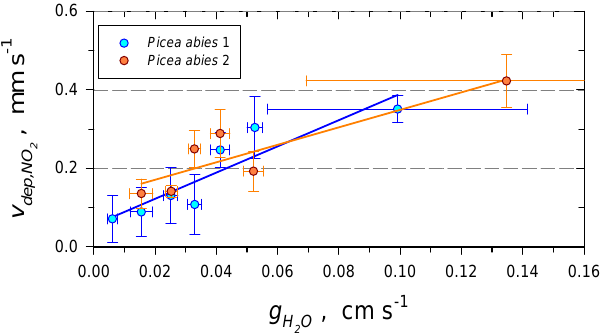
) in relationship to the 2 ) . Deposition velocities were de- 2 O